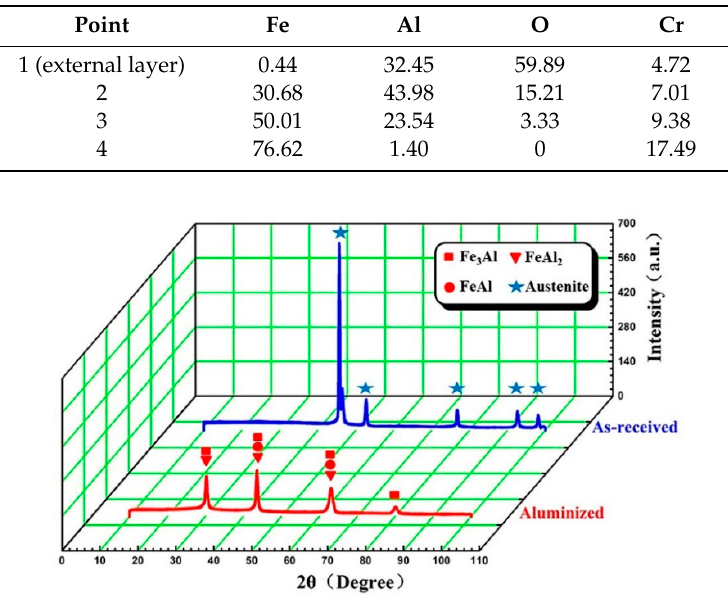
Figure 3. X-ray diffractometer (XRD) data of as-received steel and aluminized steel.